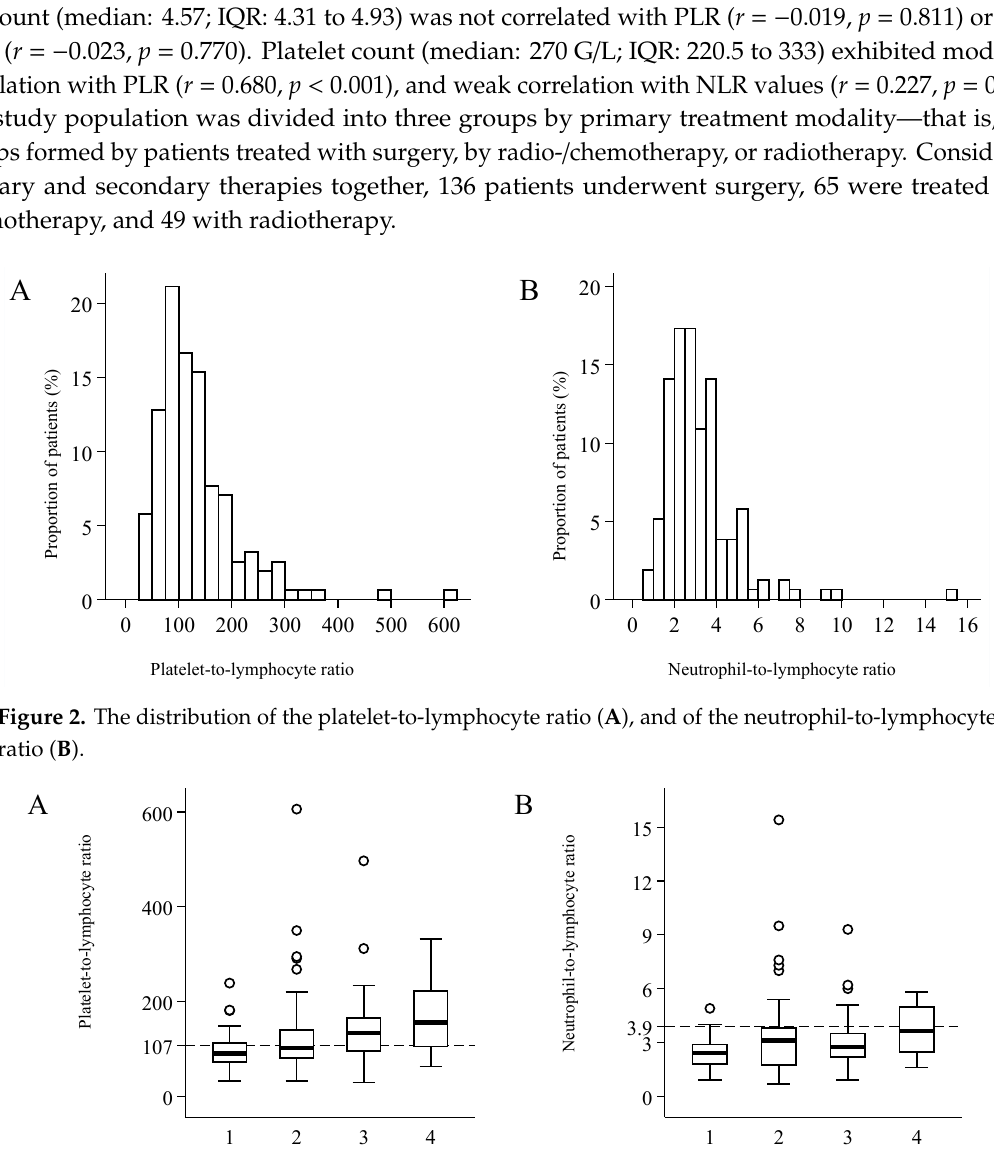
Figure 3. The platelet-to-lymphocyte ratio ( A ), and the neutrophil-to-lymphocyte ratio ( B ) in subgroups defined according to the stage and the location of the primary tumour (T).